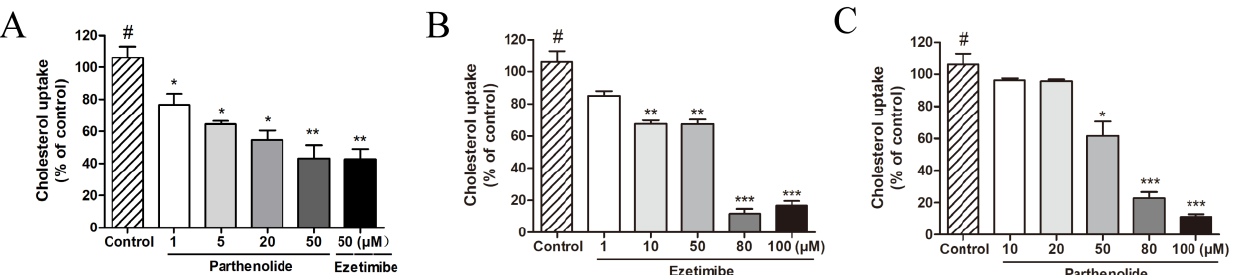
Figure 1. ( A ) Inhibitory effect of PTL on cholesterol absorption in Caco ‐ 2 cells. Caco ‐ 2 cells were pretreated with PTL at different concentrations for 4 h and then incubated with NBD ‐ cholesterol for 1 h. ( B ) Inhibitory effect of ezetimibe on cholesterol absorption in HepG2 cells. HepG2 cells were pretreated with ezetimibe at different concentrations for 4 h and then incubated with NBD ‐ cholesterol for 1 h. ( C ) Inhibitory effect of PTL on cholesterol absorption in HepG2 cells. HepG2 cells were pretreated with PTL at different concentrations for 4 h and then incubated with NBD ‐ cholesterol for 1 h. Values are expressed as mean ± SD of three to five experiments. ( # : control, * p < 0.05, ** p < 0.01, *** p < 0.001, compared to control).